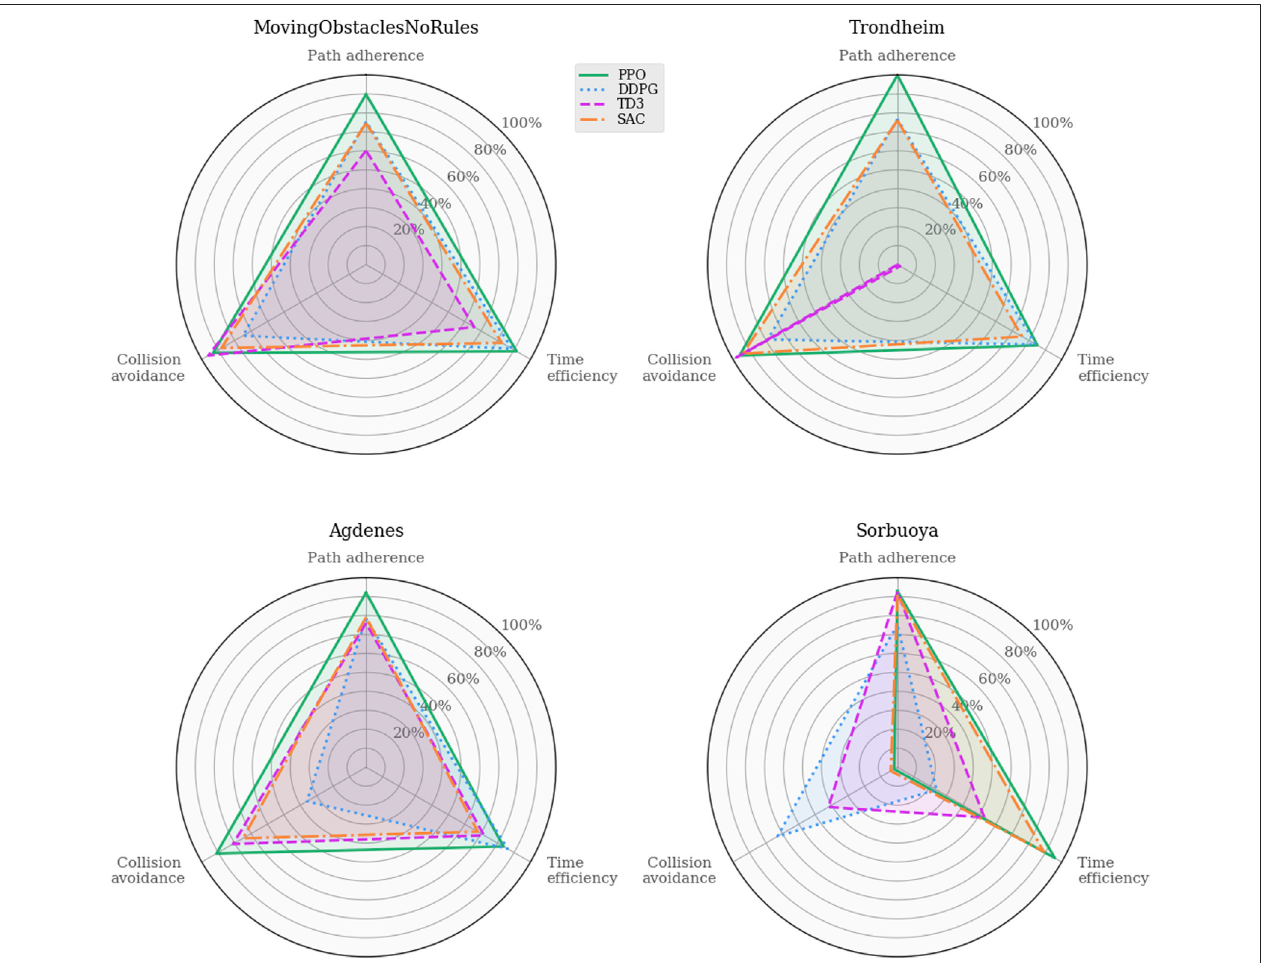
FIGURE 10 | Performance analysis of task-speci fi c metrics across simulation environments. These results provide insight into the agents ’ trade-off between the path following and collision avoidance tasks. Their behaviors are similarly well-rounded in MovingObstaclesNoRules, and the discrepancies start to show when the agents are generalized to real-world